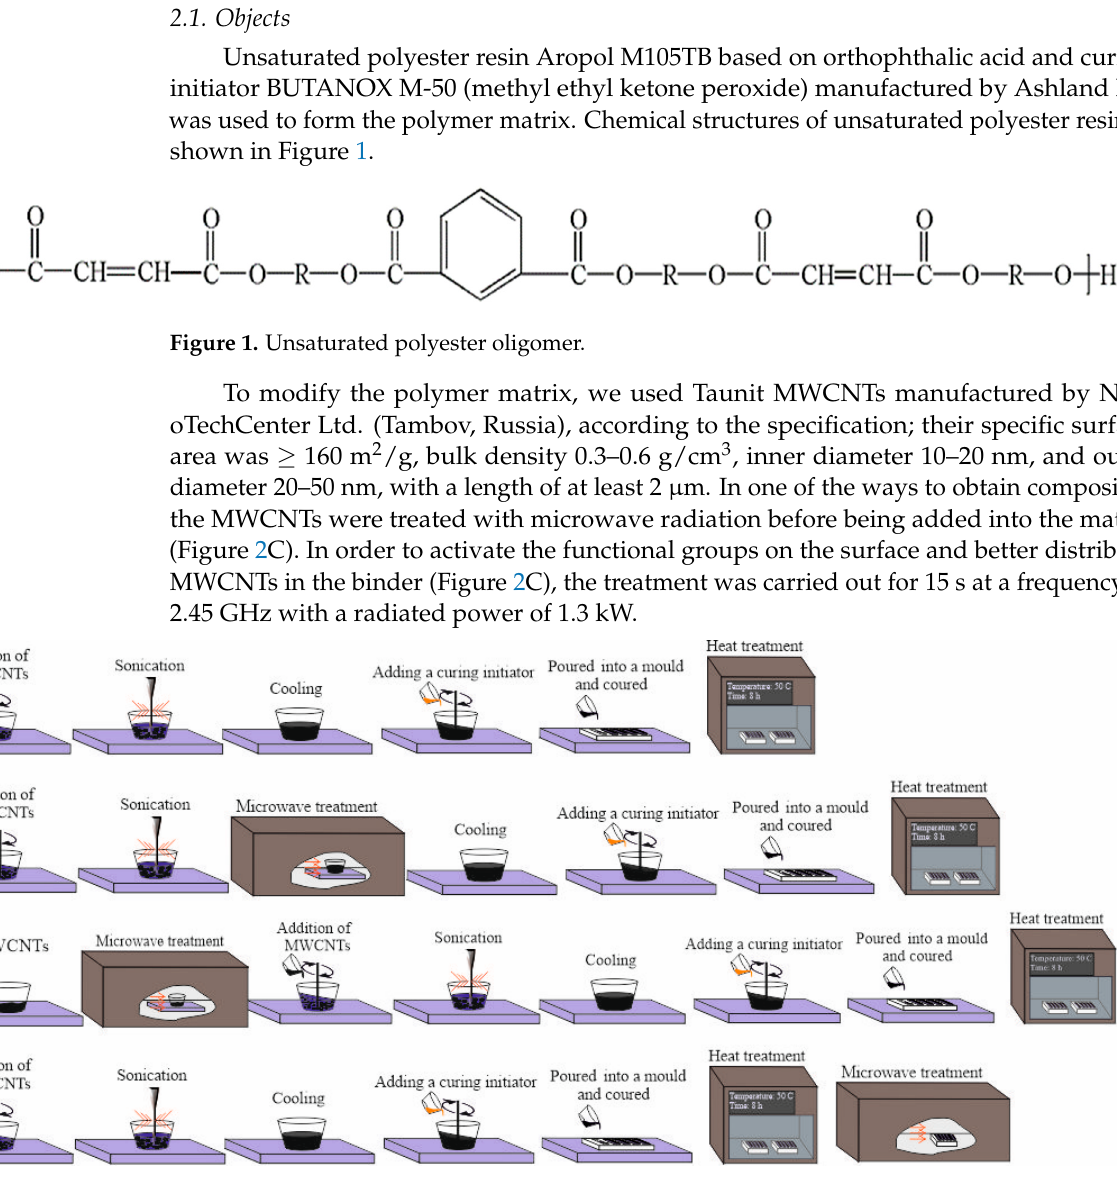
Figure 2. Schematic illustration for the preparation process of MWCNTs/UP nanocomposites: (a) UPR + MWCNTs; (b) UPR + MWCNTs + oligomer microwave treatment; (c) UPR + MWCNTs microwave treatment; (d) UPR + MWCNTs + composite microwave treatment